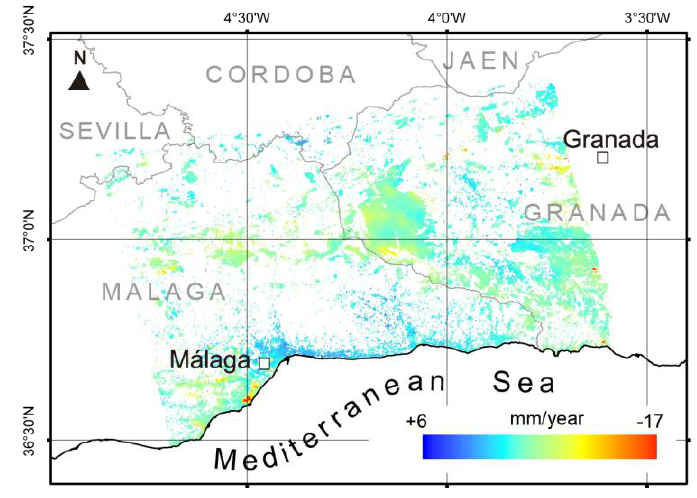
Figure 3. Surface velocity map produced by SBAS InSAR service in the study area.